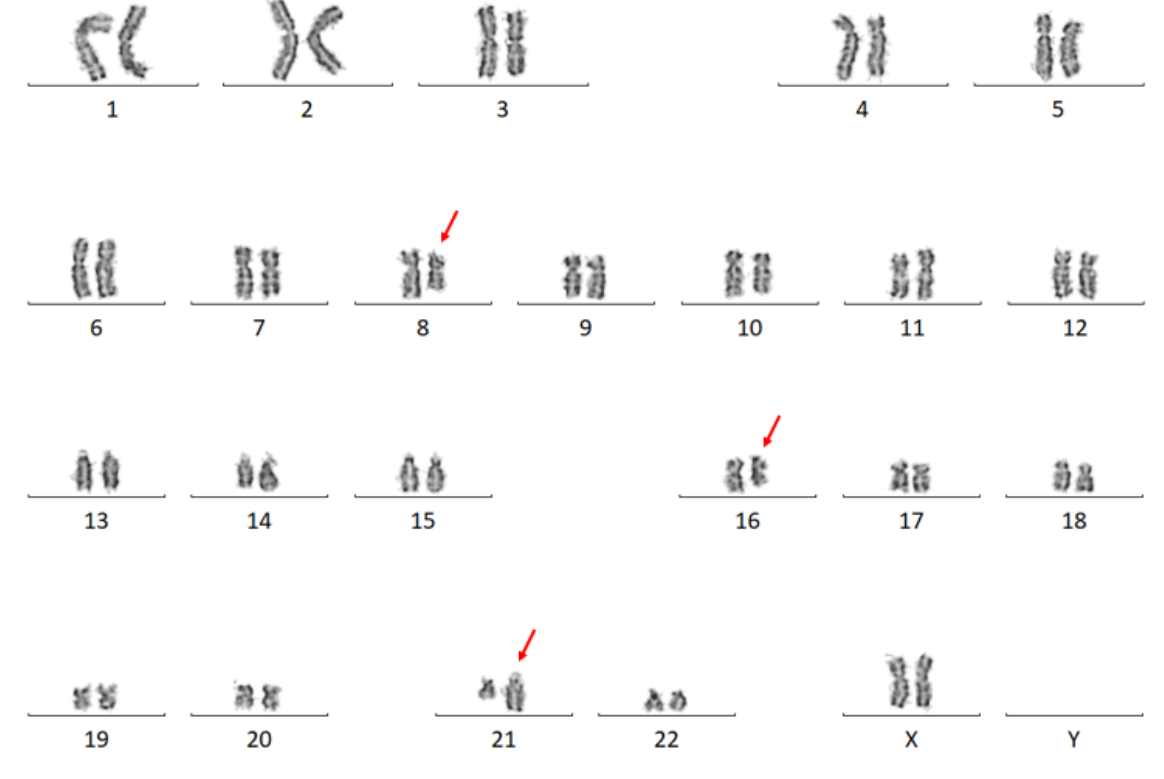
Figure 3. A representative karyogram of Patient 3: 46,XX,t(8;16;21)(q22;q12-13;q22). Because no sample was submitted for this patient, molecular testing was not